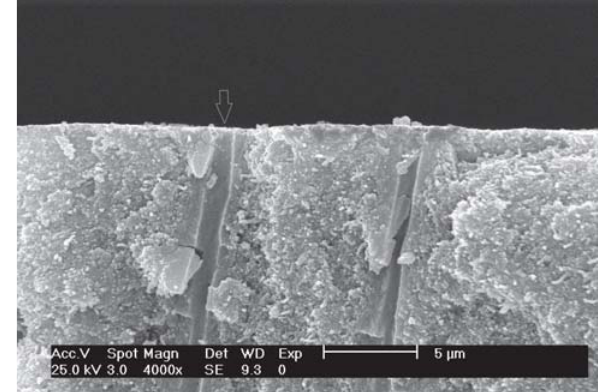
FIGURE 6 - SEM micrograph of group 3 (iBond) - Occlusal view of dentin surface. Observe the cuff-like aspect of the peritubular dentin (arrowhead) and some partially occluded tubules (arrow) (x8,000)